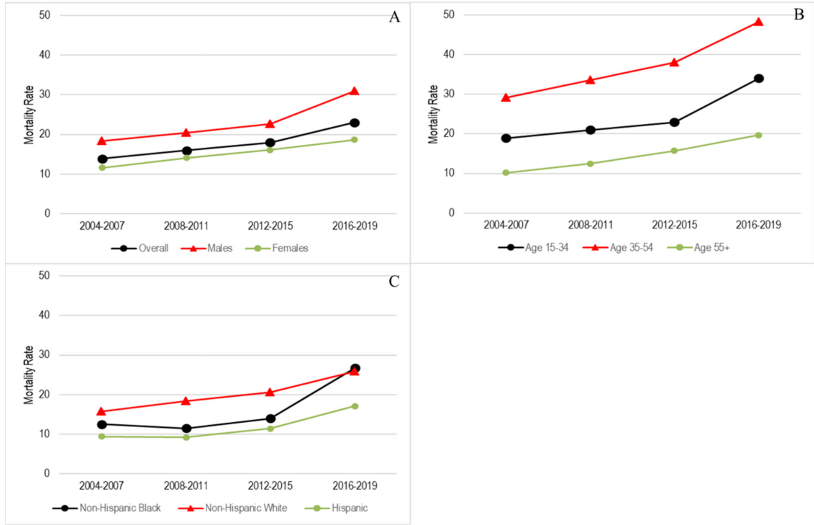
Figure 1. Unadjusted drug mortality rates among the total population and sociodemographic sub- groups since the Great Recession, The Wide-Ranging Online Data for Epidemiologic Research, 2004–2019. Note: drug mortality rate indicates county-level crude drug mortality rates per 100,000 persons. ( A ) Drug mortality rates overall and by sex; ( B ) Drug mortality rates by age groups; ( C ) Drug mortality rates by race/ethnicity.